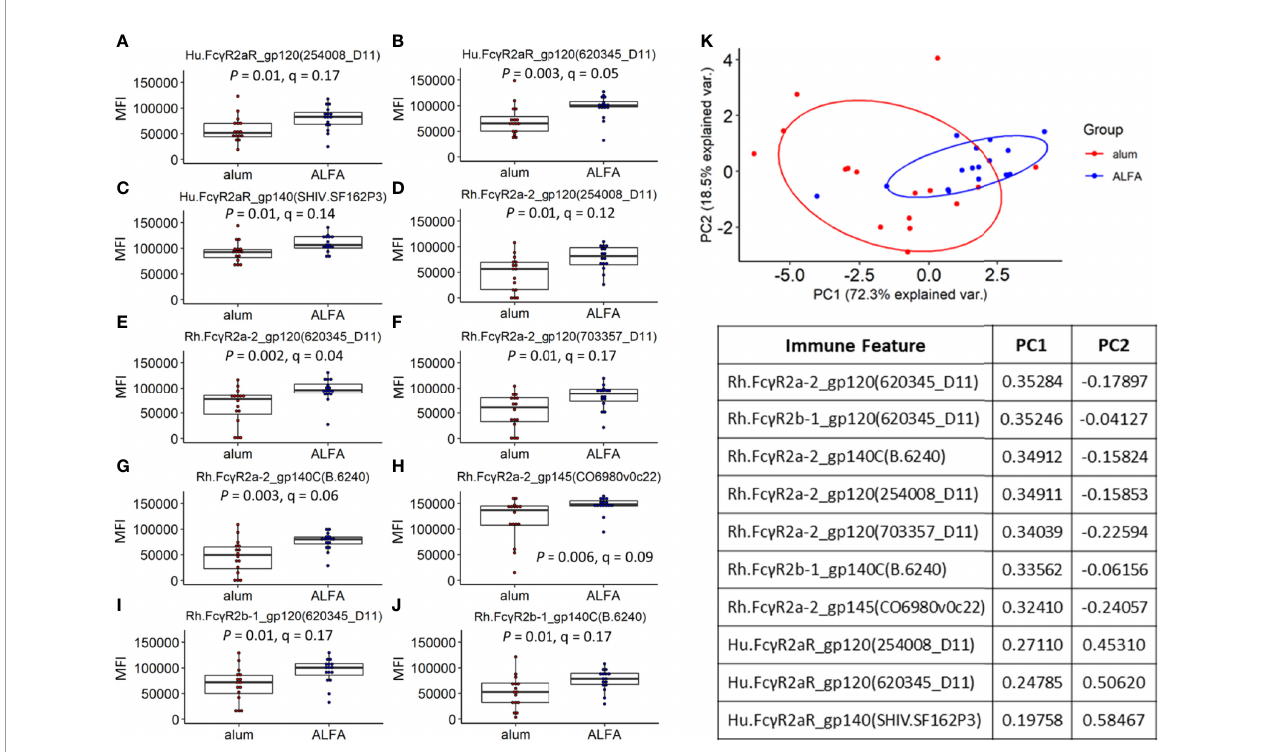
FIGURE 3 | Vaccine-elicited immune responses that vary by adjuvant. (A – J) Vaccine-elicited binding antibody responses differing between the ALFA and alum active arms are shown for each Fc detection reagent and HIV-1 Env antigen combination. MFI, median fl uorescence intensity. (K) Principal component analysis on adjuvant-associated immune